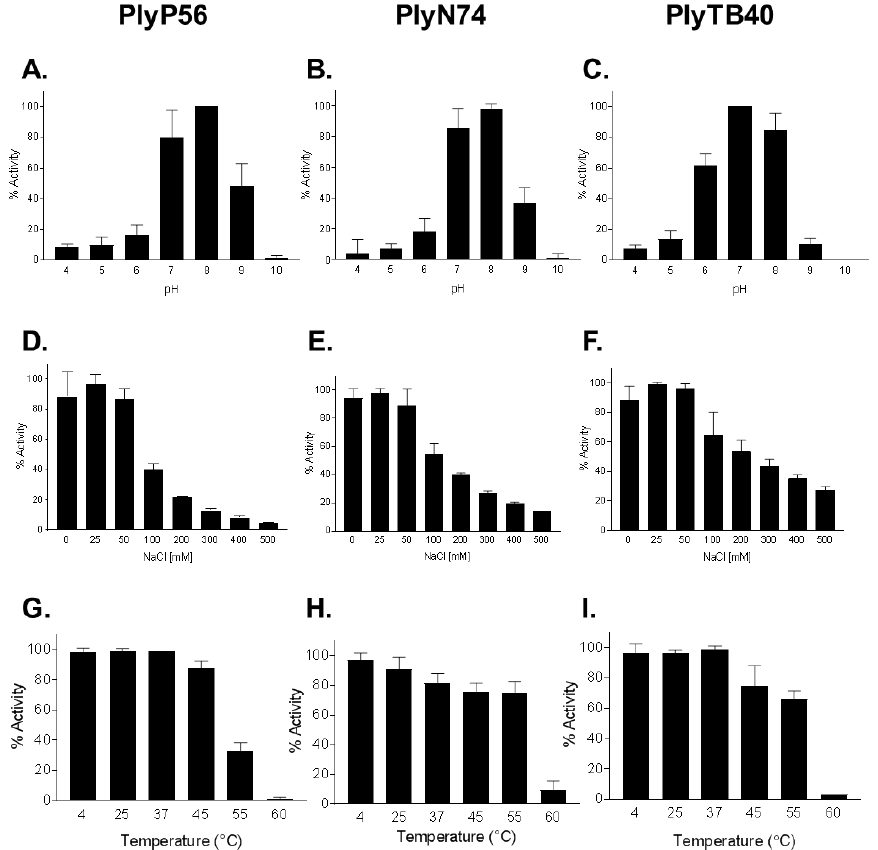
Figure 4. Biochemical characterization of optimal conditions for Bacillus bacteriophage endolysins activity. The effects of pH ( A – C ), NaCl dependence ( D – F ), and temperature stability ( G – I ) was evaluated for each of the three endolysins. PlyP56 ( A , D , G ), PlyN74 ( B , E , H ), and PlyTB40 ( C , F , I ) were assayed for lytic activity, each at 50 μg/mL, and tested separately via turbidity reduction assay against stationary phase B. cereus ATCC 4342 cells for 20 min. The temperature effect on lytic activity was tested after endolysins were preincubated at indicated temperatures for 30 min and subsequently recovered on ice for 5 min. Values are presented as a percentage of lytic activity in relation to highest activity observed for each tested parameter. The experiments were run in triplicates on three independent days. Error bars indicate standard deviations.